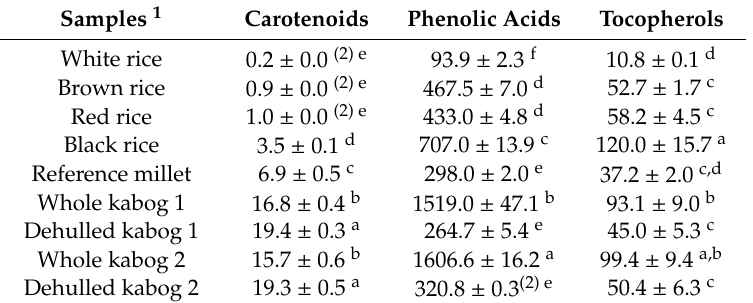
Table 2. Total carotenoid, tocopherol, and phenolic acid content of rice (white, brown, red, and black), reference millet, and kabog millet (whole and dehulled) samples expressed in µ g /